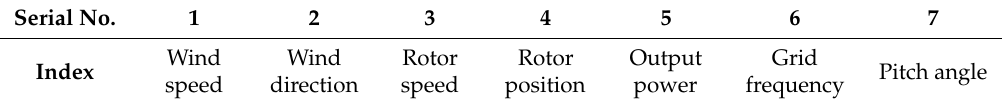
Table 7. Indicator parameters related to pitch system